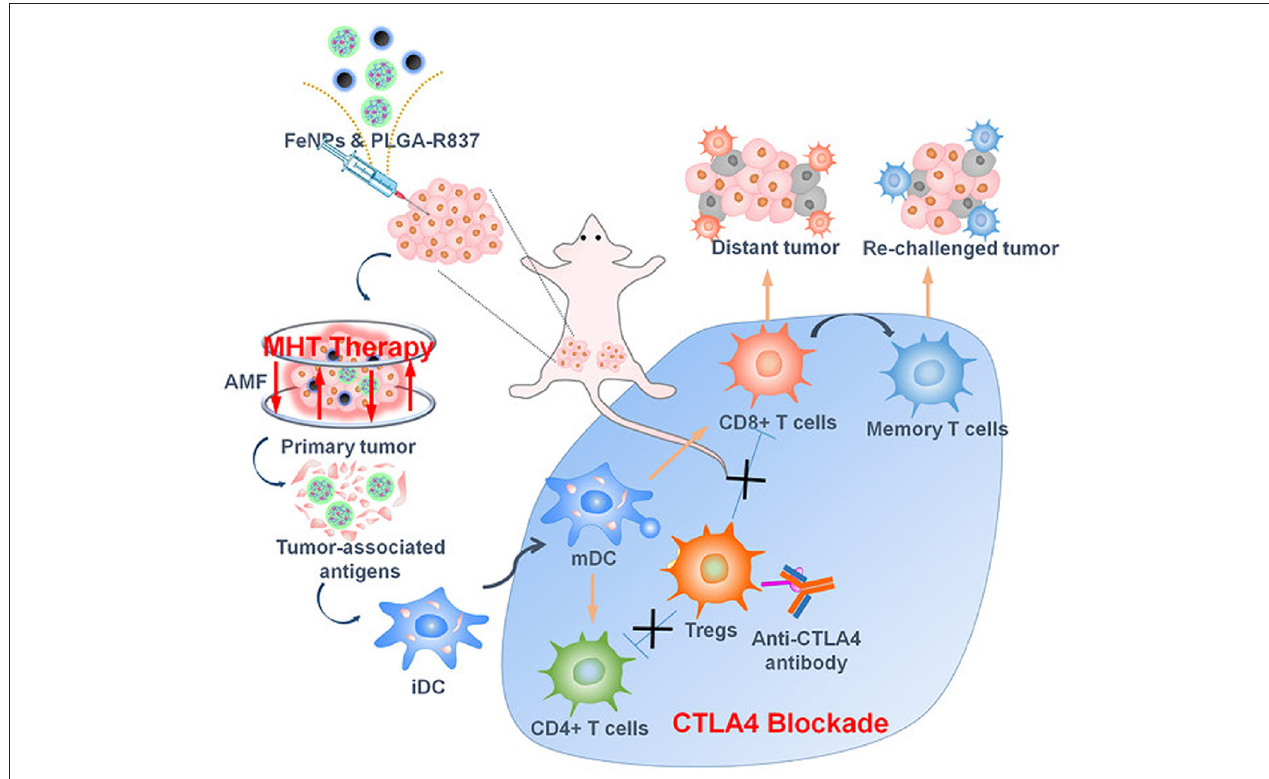
FIGURE 12 | Mechanism of toll-like receptor (TLR)-7 agonist-based iron oxide nanoparticle (IONP) delivery with a checkpoint blockade antibody for alternative magnetic field (AMF)-induced magnetic hyperthermia and immune therapy. Reproduced from Chao et al. (2019) Copyright © 2019, American Chemical Society .